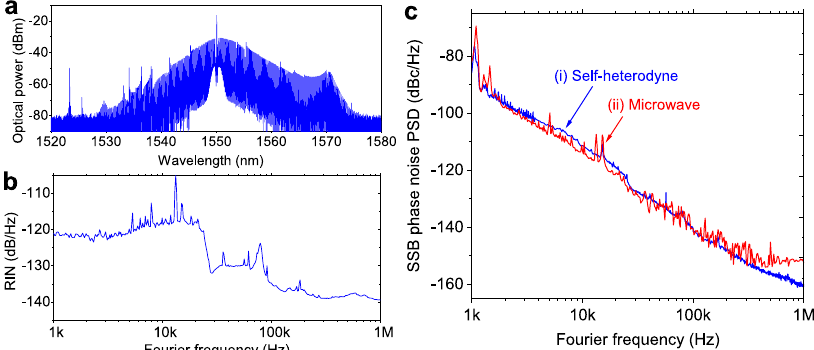
Fig. 2 Properties of the free-running silica microcomb. a Optical spectrum of the silica microcomb. b Relative intensity noise (RIN) of the microcomb. Note that the sudden jump at 20 kHz is due to the response of the PZT in the pump laser. c Repetition-rate phase noise of the free-running microcomb measured in the (i) optical domain and (ii) microwave domain. Source data for Fig. 2a, b and c are provided in the Supplementary Information.